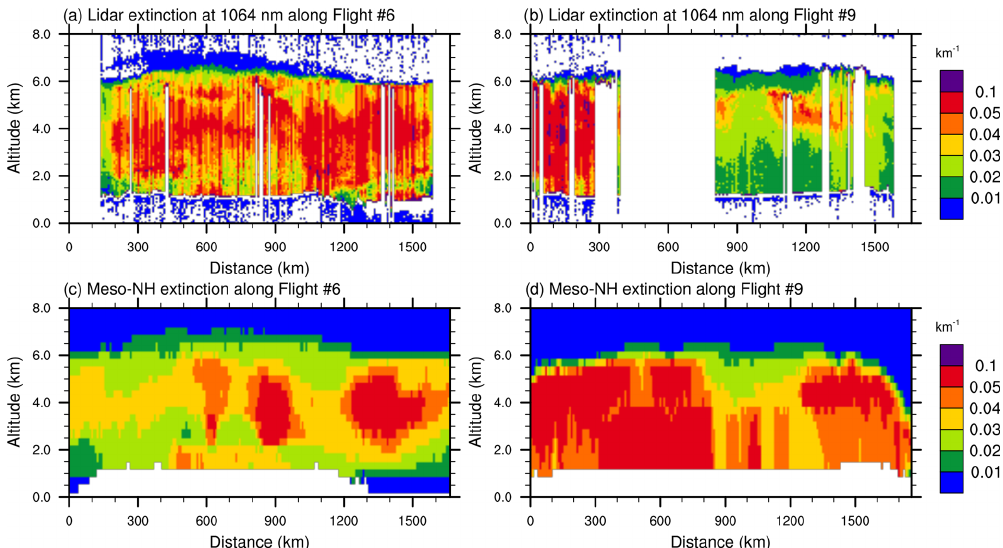
Figure 9. (a) Distance–height cross section of the extinction coefficient derived at 1064nm from LNG along the flight track of the Falcon 20 on 5 September from 07:36 to 10:14UTC (see Fig. 1b). (b) Same as (a) but on 6 September from 10:55 to 14:01UTC. (c) BB carbon tracer concentration as simulated with Meso-NH at 09:00UTC 5 September 2017 along the Falcon 20 flight track. (d) Same as (c) but at 12:00UTC on 6